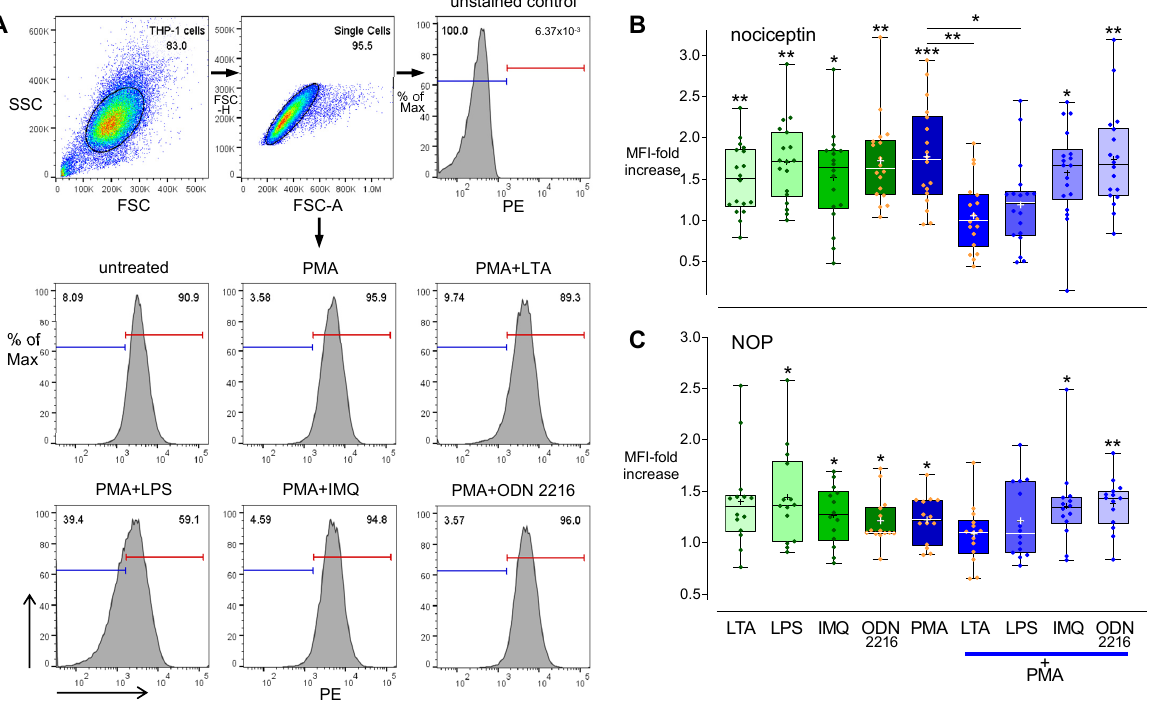
Figure 7. Effects of TLR agonists on the regulation of nociceptin and NOP proteins by PMA in THP ‐ 1 cells. Cells were cultured with or without different TLR agonists specific for TLR2 (LTA 10 μ g/mL), TLR4 (LPS 100 ng/mL), TLR7 (IMQ 10 μ g/mL), TLR9 (ODN 2216 1 μ M), and with or without PMA for 24 h. ( A ) Representative histogram plots of intracellular nociceptin protein levels in THP ‐ 1 cells treated with or without PMA 5 ng/mL and PMA+TLR agonists (blue and red lines: setting of gates). Flow cytometric analysis of intracellular nociceptin ( B ) and membrane NOP protein levels ( C ). Flow cytometry data are presented as mean fluorescence intensity (MFI) related to the respective un ‐ treated groups. Boxplots with individual data points, median, IQR, and mean “+”; n = 18. Wilcoxon test with correction for multiple testing. *, p < 0.05; **, p < 0.01; ***, p < 0.001. Table 2. Effects of TLR agonists on the regulation of ppNOC and NOP mRNA expression by PMA in THP ‐ 1 cells.